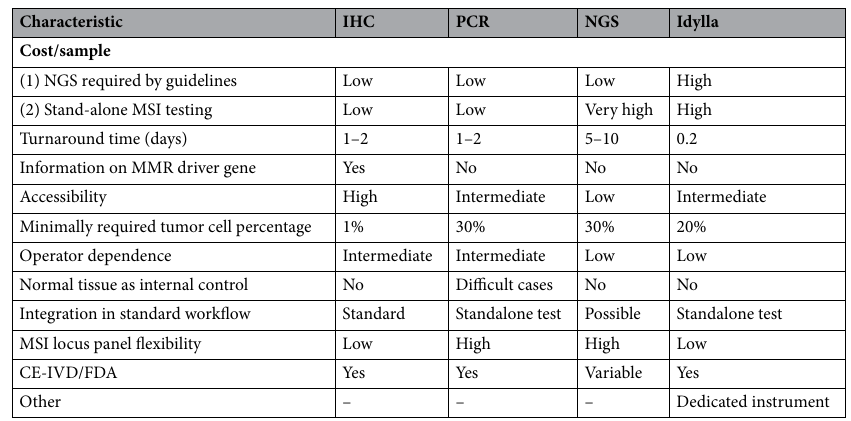
Table 3. Pros and cons of IHC versus molecular methods. The table lists some pros and cons of IHC and the three molecular MSI tests. Generally, for tumor types that undergo default NGS analysis, the total runcost of NGS is very low once the investment in bioinformatic scripts and MSI integration in panel design are made and overall flexibility of MSI panel design and data analysis is very high. Idylla MSI assay is interesting for labs with low sample number and limited operator experience but requires a dedicated separate analyser and the closed systems limits analysis of locus-specific indel distribution patterns. PCR is inexpensive and currently considered as reference test along IHC but its dependence on experienced operators is